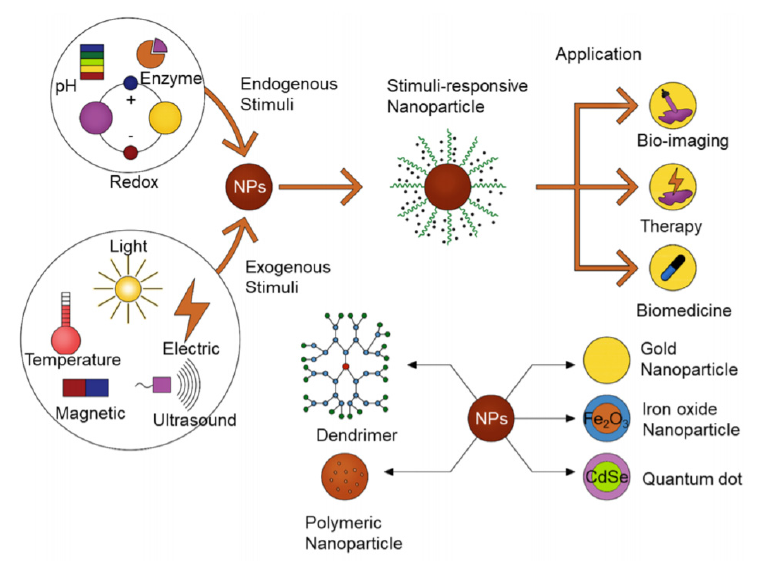
Figure 5. A schematic illustration of stimuli-responsive nanomaterials for different applications including therapy, bio-imaging as well as triggered drug release (Reprinted from ref. [144] ).